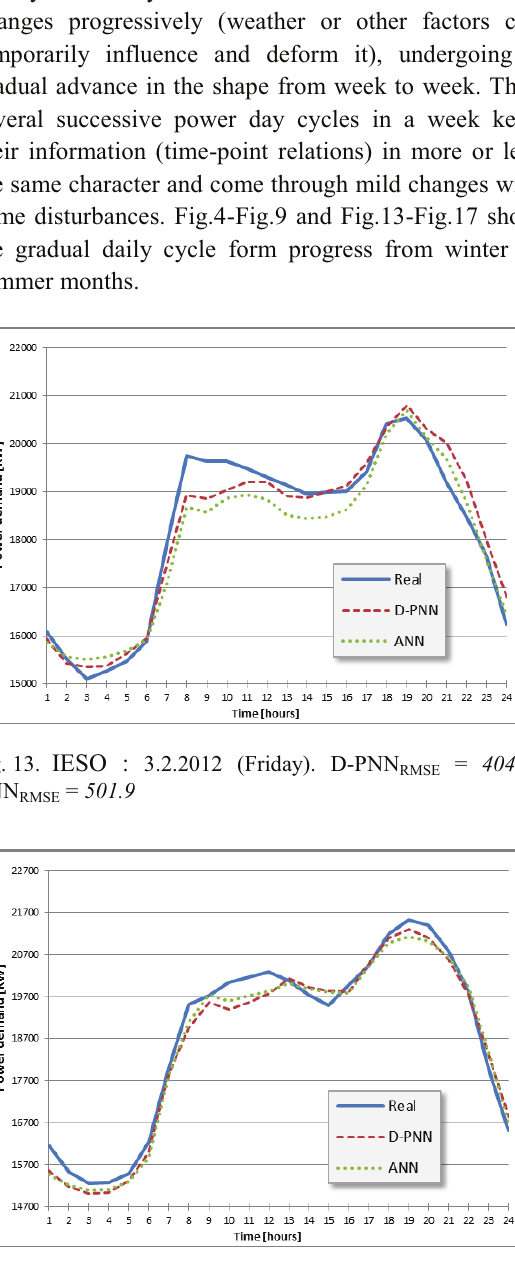
Fig. 14. IESO : 1.3.2012 (Thursday). D-PNN RMSE = 335.0 , ANN RMSE =